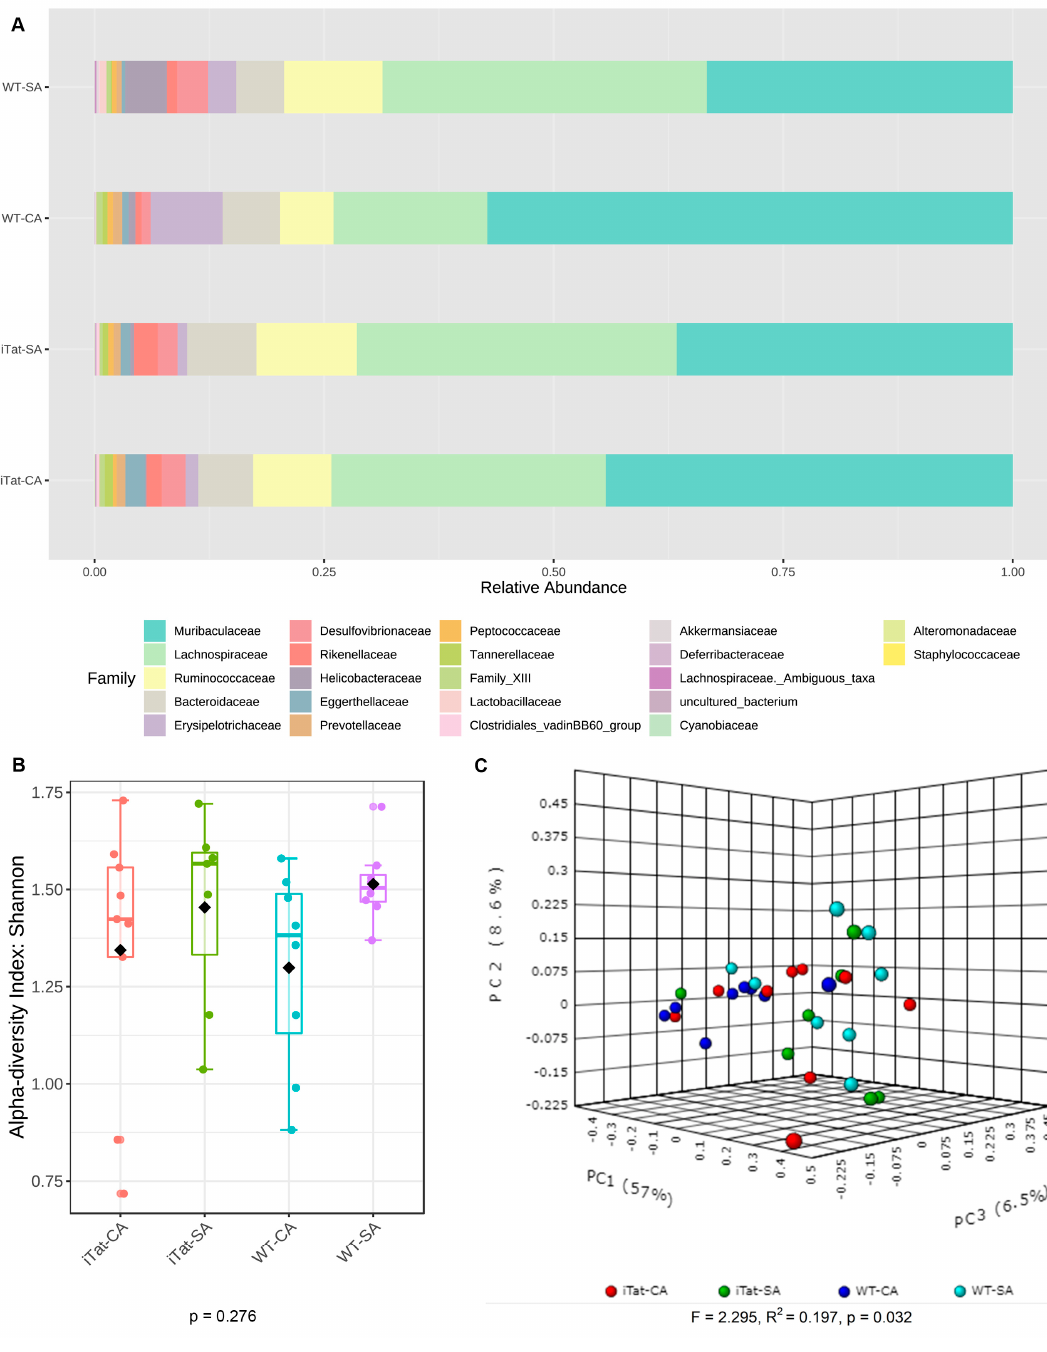
Figure 3. Effects of Tat expression and cocaine exposure on microbial abundance and diversity in the gut of 6-month-old male mice. ( A ). Relative abundance (%) of top 22 families of gut microbiota in four experimental groups WT-SA, WT-CA. iTat-SA, and iTat-CA were presented as a stacked bar plot. ( B ). Shannon index was calculated to determine α -diversity of the gut microbiota in four experimental groups: WT-SA, WT-CA. iTat-SA, and iTat-CA, presented as a box plot, and analyzed using the Kruskal–Wallis test. The error bars were standard derivation (SD). ( C ). Bray–Curtis dissimilarity was calculated to determine β -diversity, presented as a PCoA plot, and analyzed using PERMANOVA. The percentage variations in the plotted principal component were indicated on the axes.